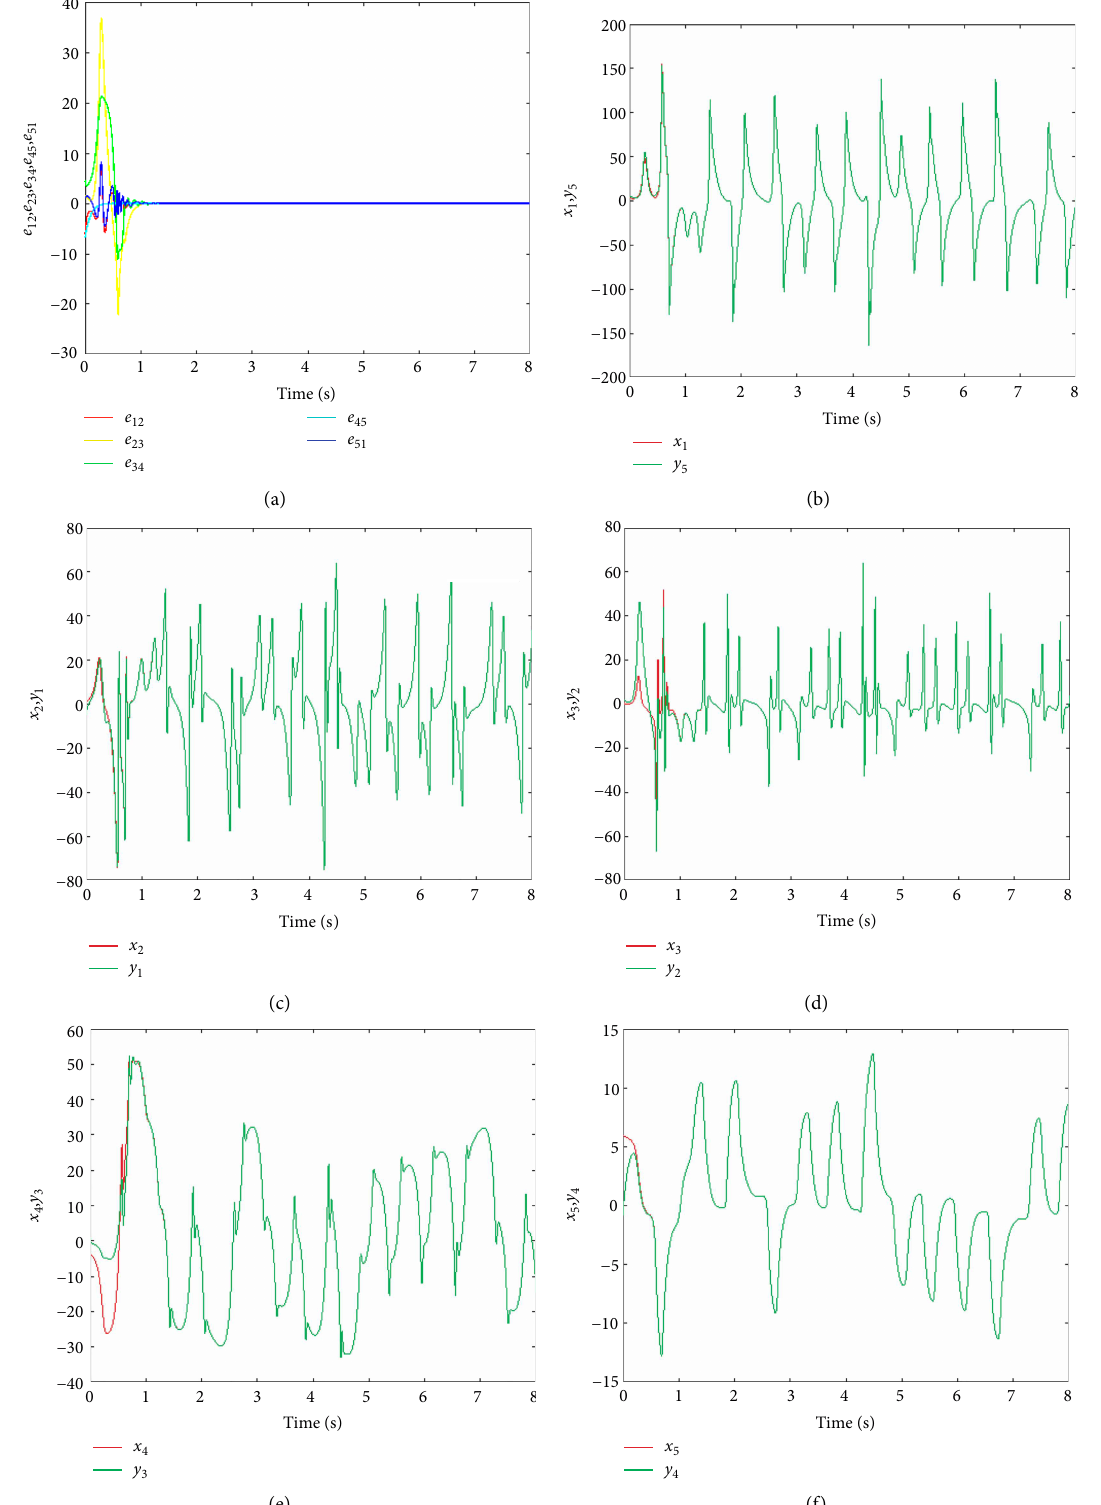
Figure 7: Switch-2: (a) the synchronization error, (b) the error of 𝑥 , (f) the error of 𝑥 𝑥 − 𝑦 4 3